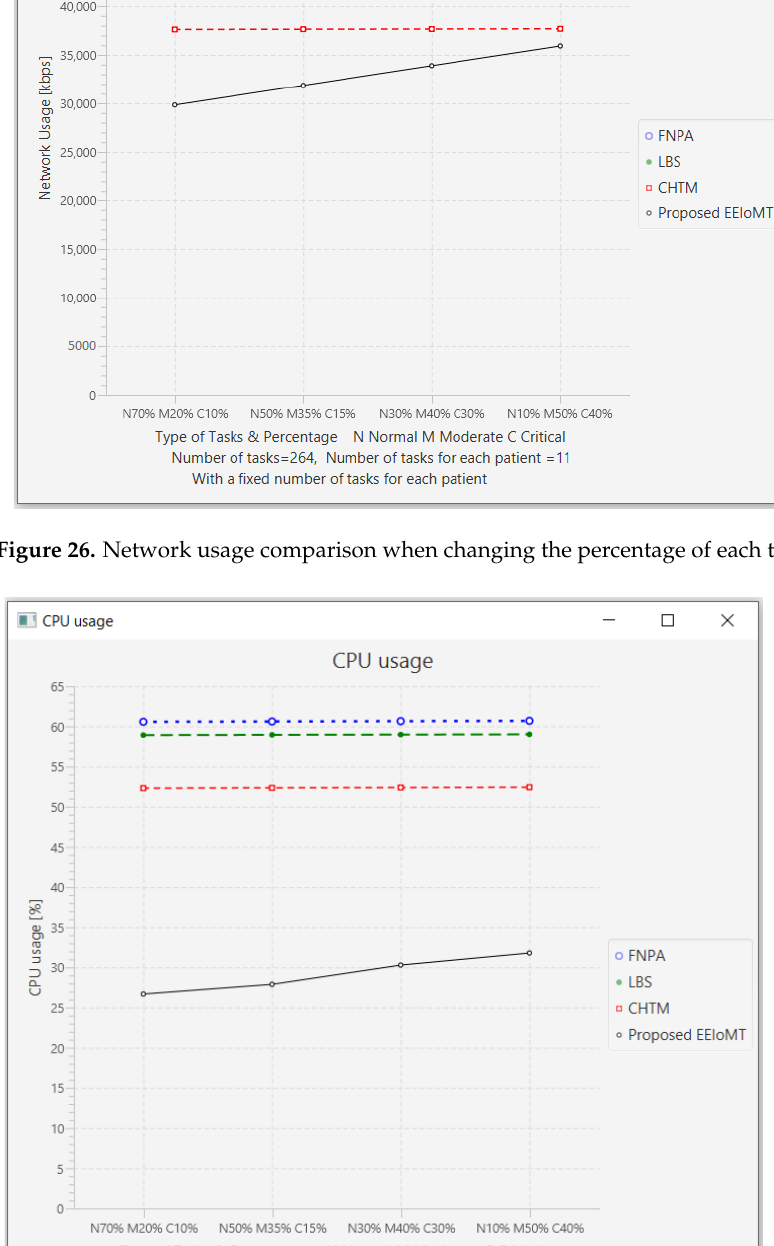
Figure 27. CPU usage comparison when changing the percentage of each type of task. Regarding latency, energy consumption, and network usage, the suggested